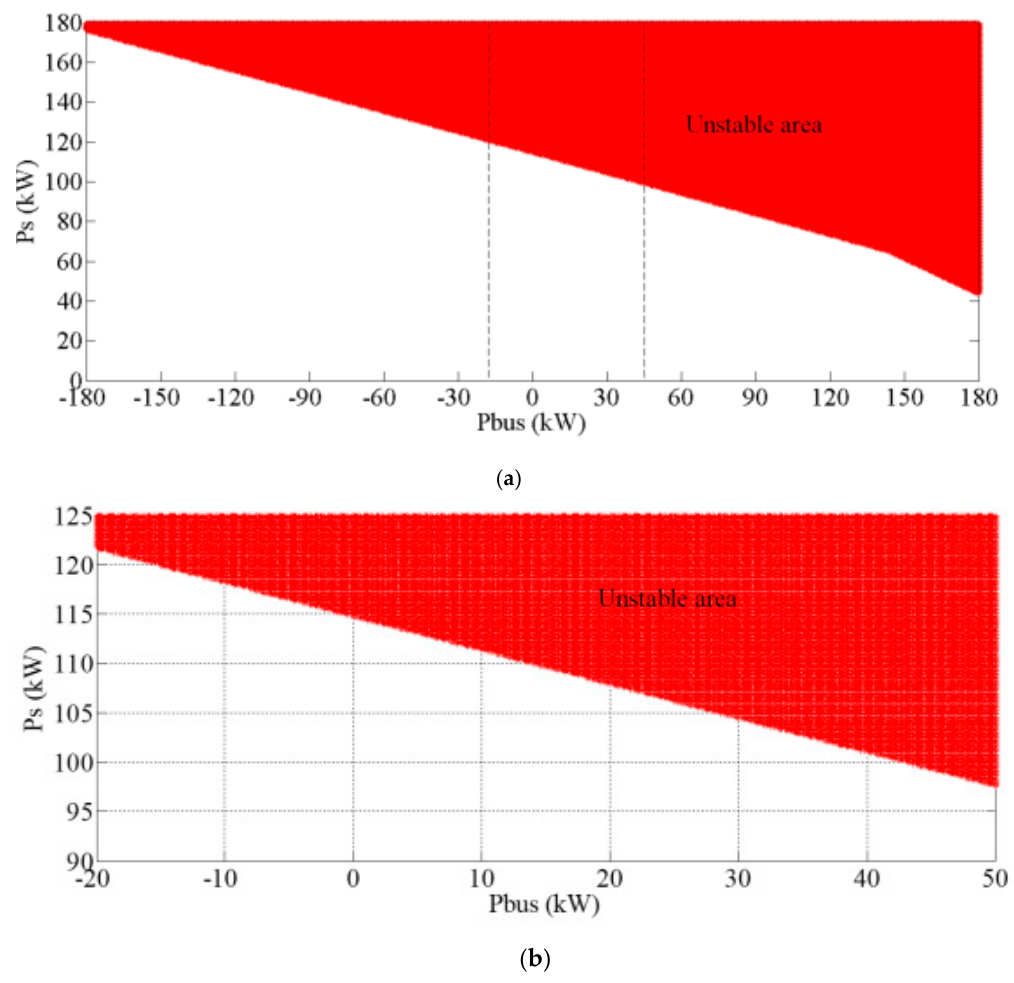
Figure 4. The power transfer boundary. ( a ) P bus from − 180 kW to 180 kW; ( b ) P bus from − 20 kW to 50 kW.